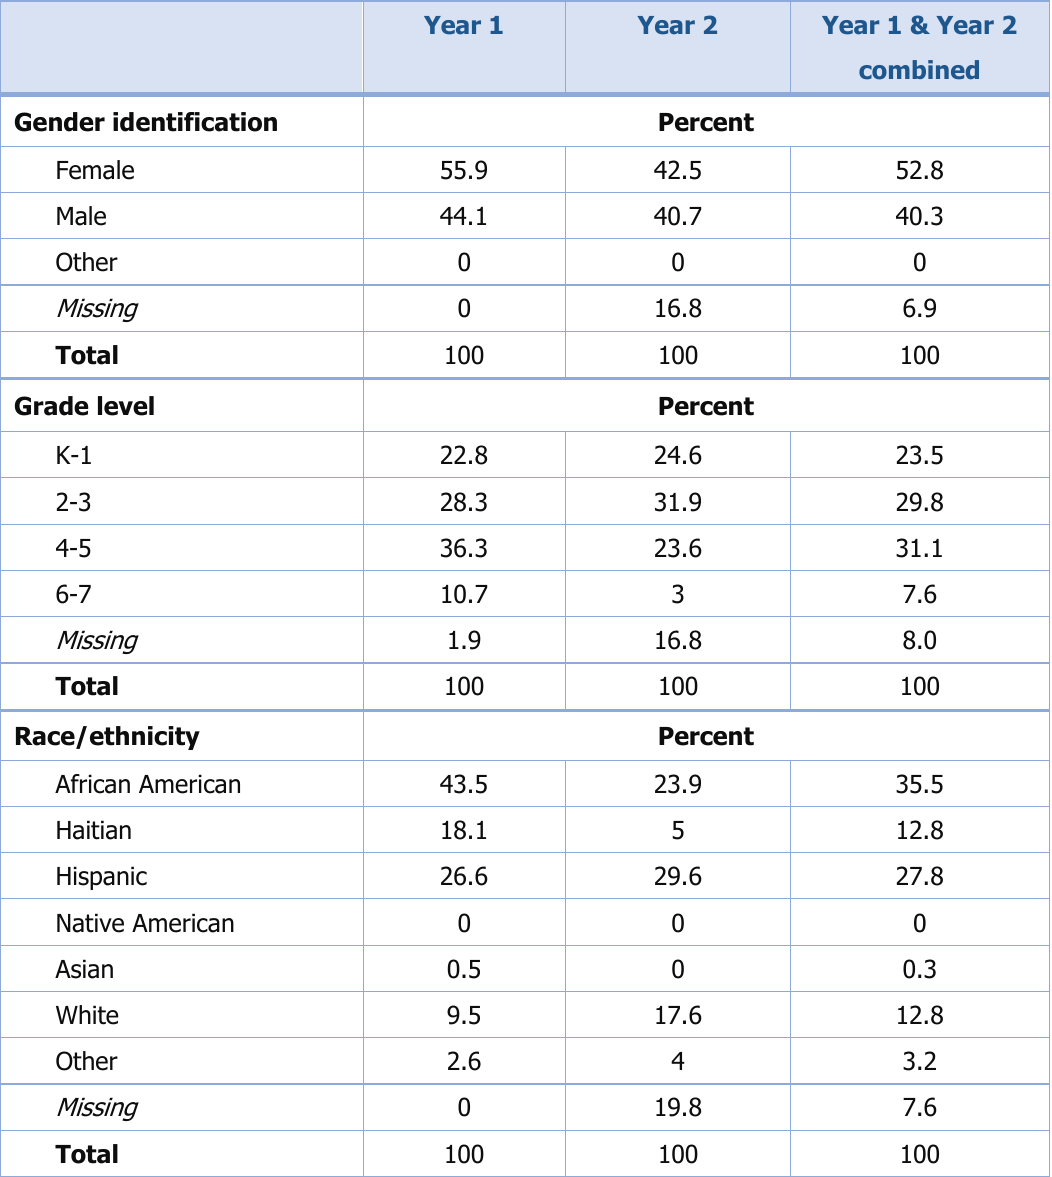
Table 3. Estimated Percentages for Gender Identification, Grade Level and Race/Ethnicity of Rated